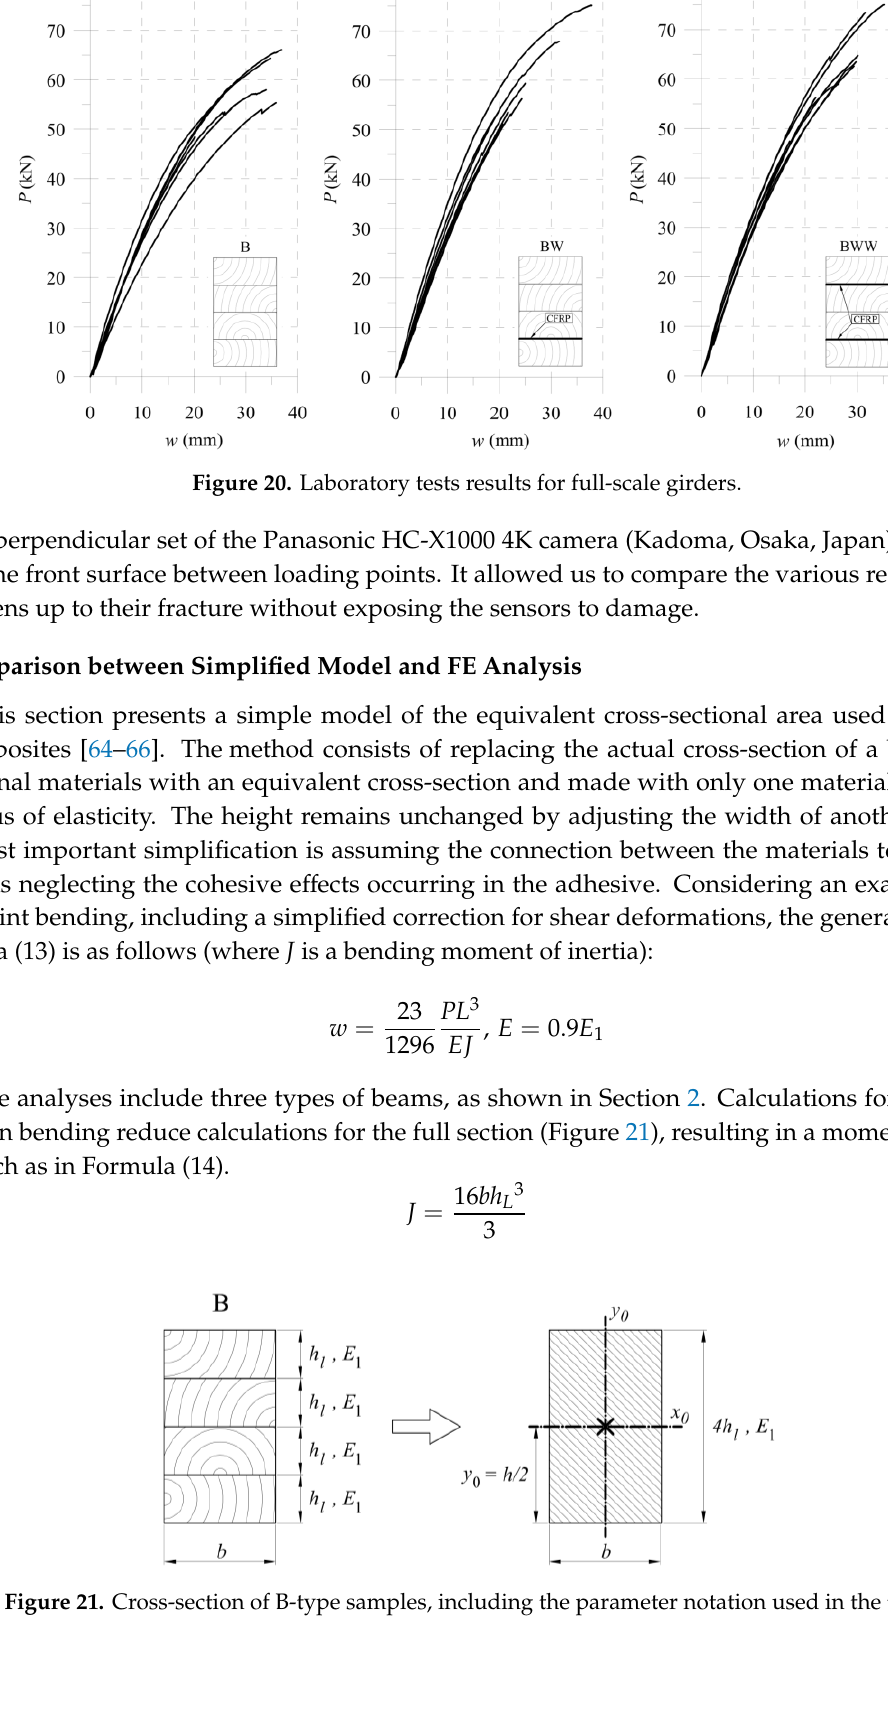
Figure 21. Cross-section of B-type samples, including the parameter notation used in the text.